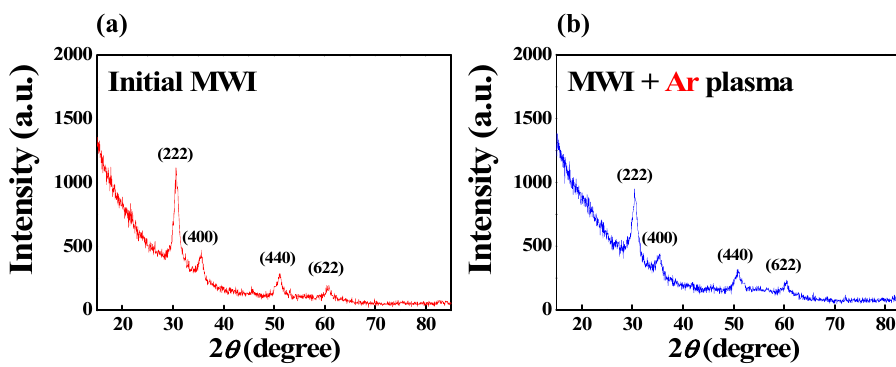
Figure 5. X-ray diffraction results of MWI ITO films ( a ) before and ( b ) after Ar plasma treatment.